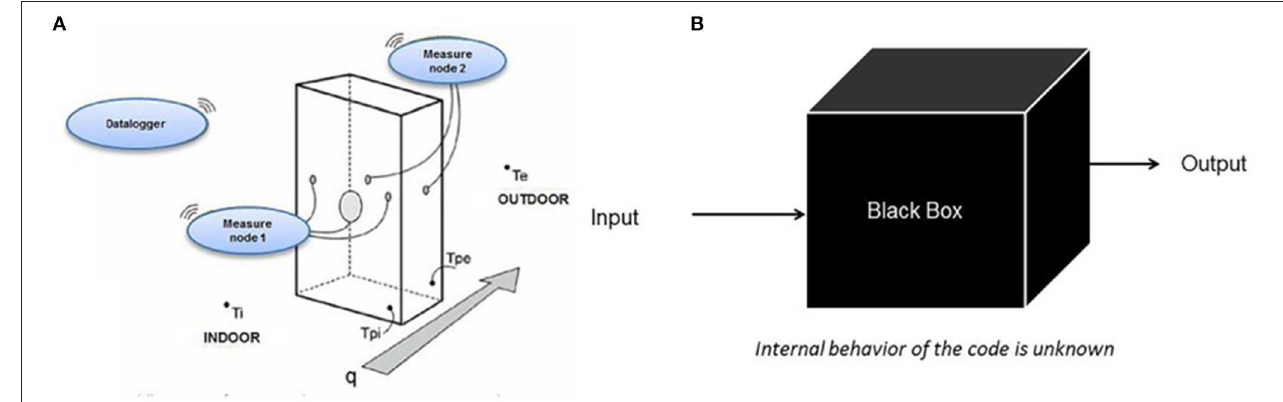
FIGURE 1 | (A) Measurement of in-situ thermal conductance and (B) scheme of the “Black-Box”